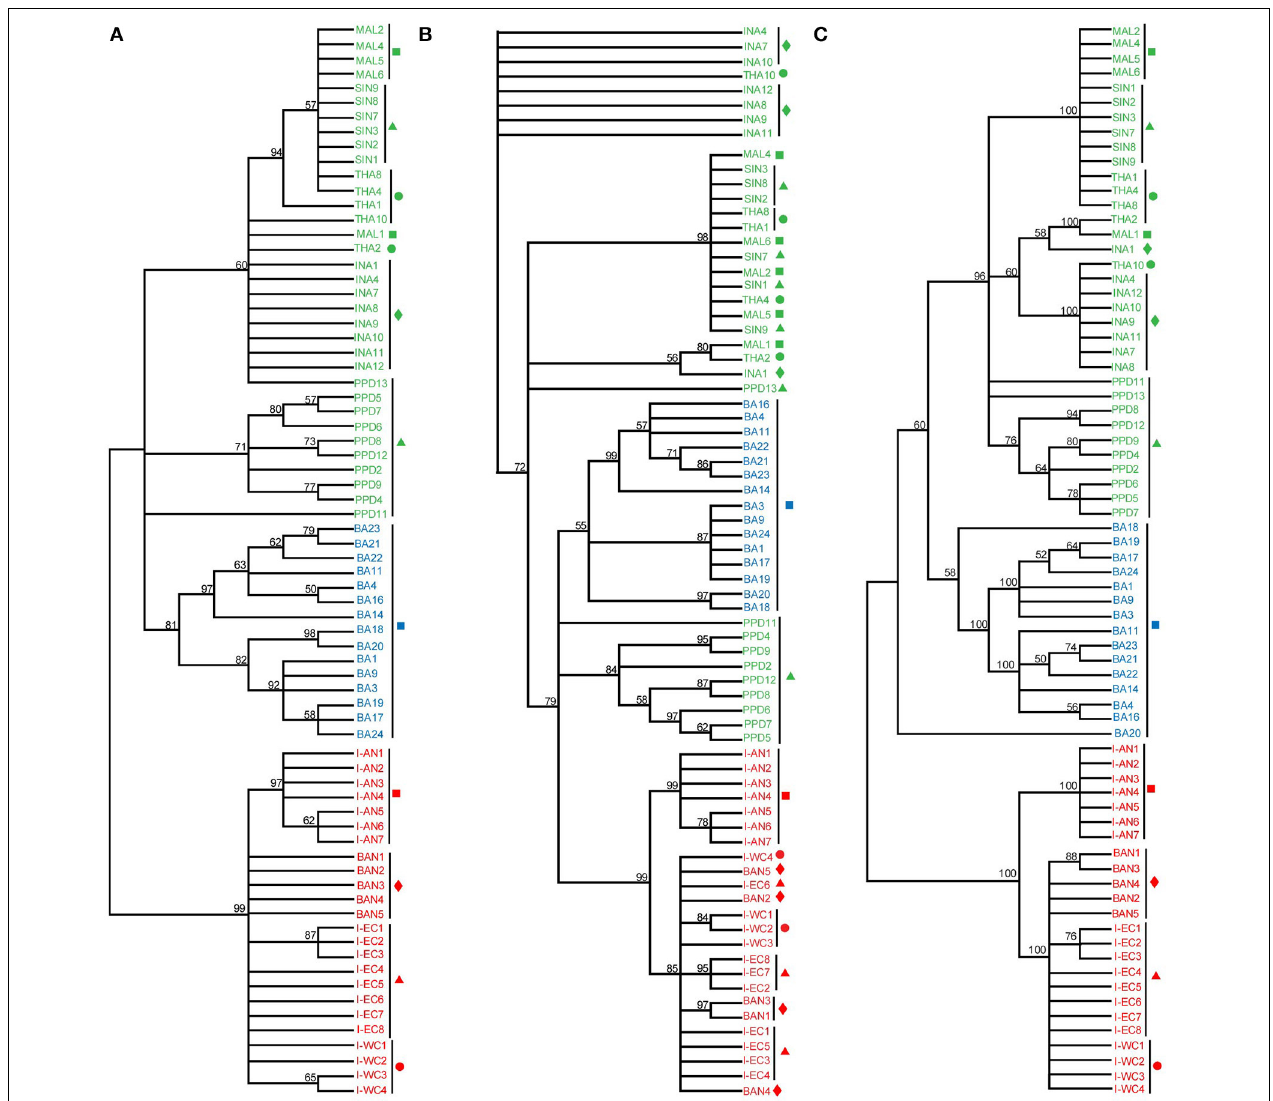
FIGURE 5 | Phylogenetic analysis based on the D-loop region. D-loop sequences from India-Western Coast (I-WC), India-Eastern Coast (I-EC), India-Andaman and Nicobar Islands (I-AN), Bangladesh (BAN), Singapore (SIN as well as PPD), Indonesia (INA), Malaysia (MAL), Thailand (THA), Australia (BA) were used for ML (A) , Maximum Parsimony (MP) (B) and Minimum Evolution (ME) (C) trees. Sequences indicated by PPD